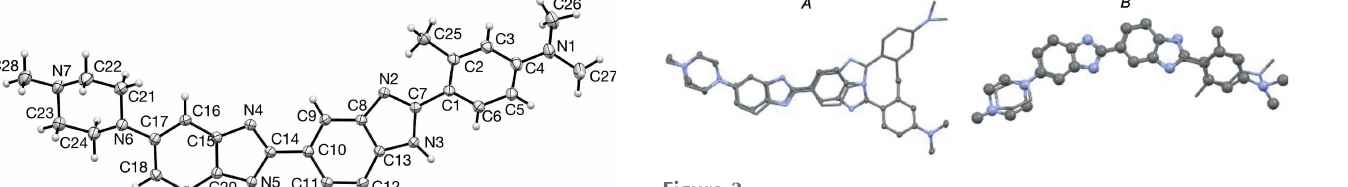
Figure 3 Overlay for the structures of A ; (1) (cid:2) 2H 2 O and B ; (1) (cid:2) H 2 O with DNA- bound (1). In the LH-structure the DNA-bond ligand is indicated by capped sticks, while in the RH structure it is ball and